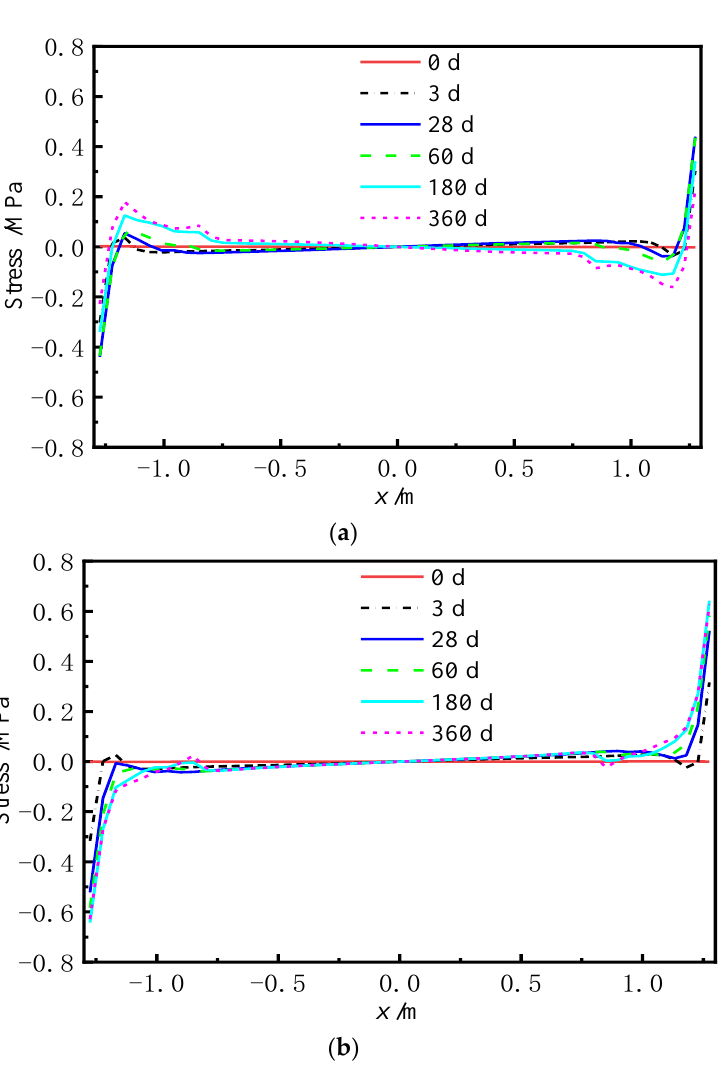
Figure 21. Interfacial stress without the shear cogging. ( a ) AOTSL of 60 d. ( b ) AOTSL of 360 d.